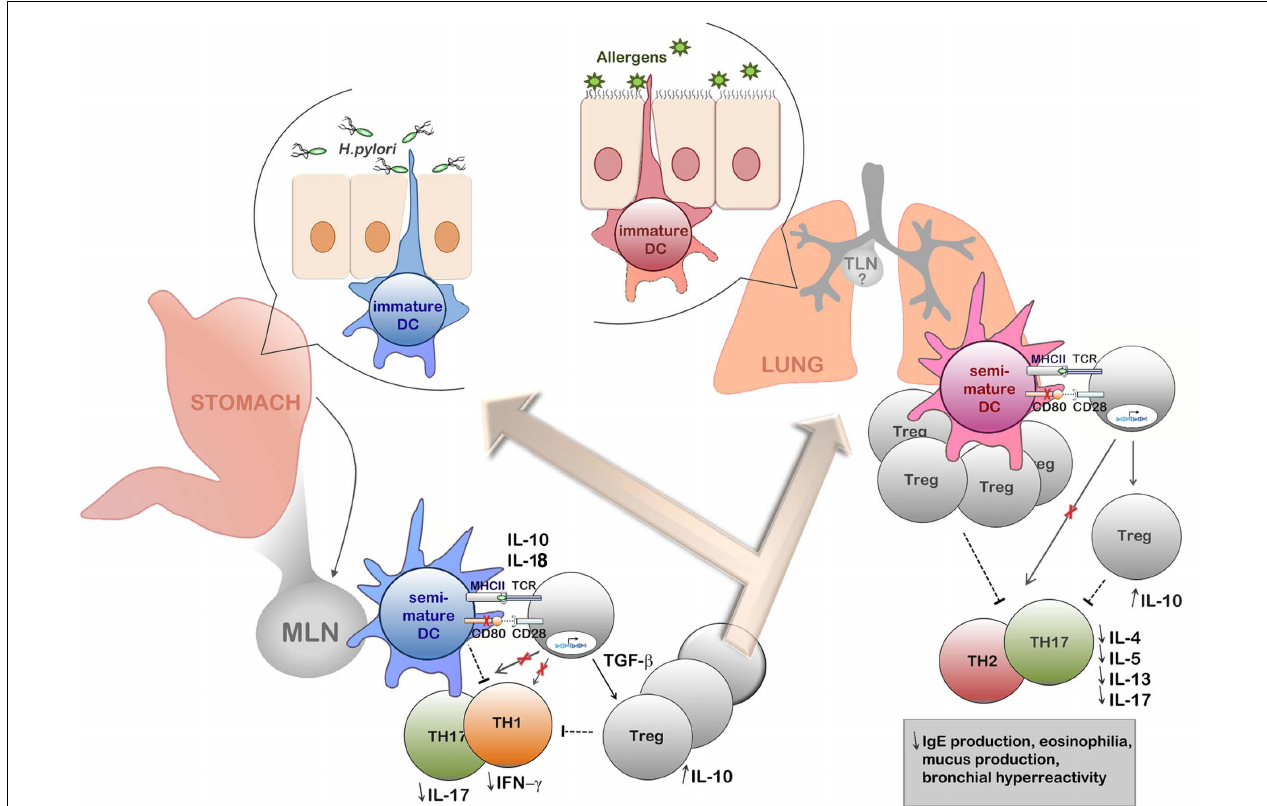
directly suppressing H. pylori -specific gastricTh1 andTh17 responses, thereby protecting the host from excessive gastric immunopathology. Newly inducedTregs further migrate to the lung, where they suppress allergen-specificTh2 andTh17 responses involved in the pathogenesis of asthma.The generation of allergicT-cell responses may be blocked either through the tolerogenic effects ofTregs on DCs (retaining DCs in a semi-mature state) or directly through suppression ofTh2 andTh17 responses viaTreg/T-effector cell contact or via soluble cytokines, in particular IL-10.The ultimate outcome of gastric H. pylori infection on the allergen-challenged lung is reduced eosinophilia, mucus production and airway hyper-responsiveness.The involvement of the tracheal lymph nodes in H. pylori -induced asthma suppression is likely, but currently not well